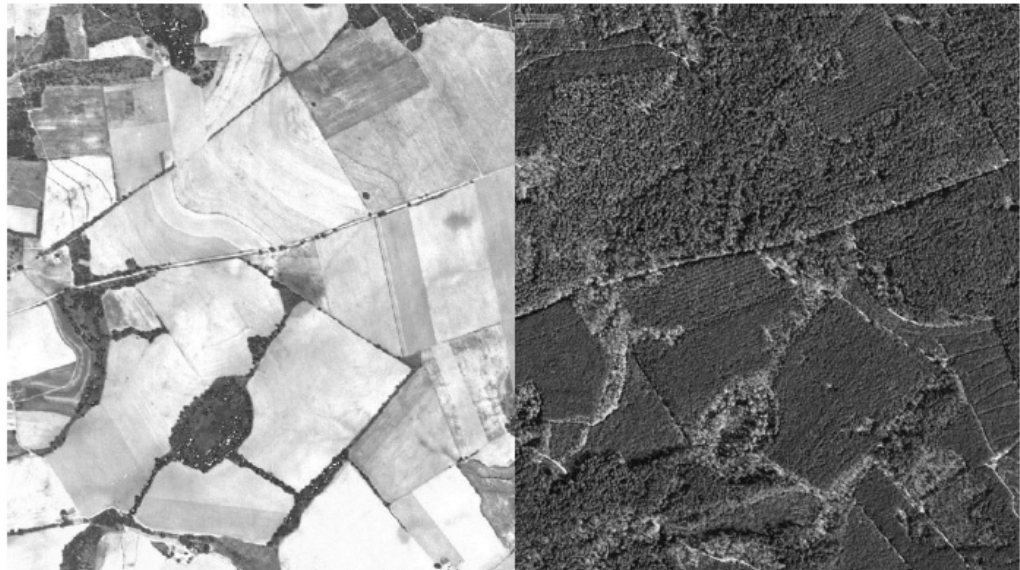
Figure 1. An aerial image from 1951 showing an area that is currently within the 80,000 ha Savannah River Site but was primarily under agriculture at that time (left), and that same area in 2001, illustrating the profound impact of afforestation across the landscape